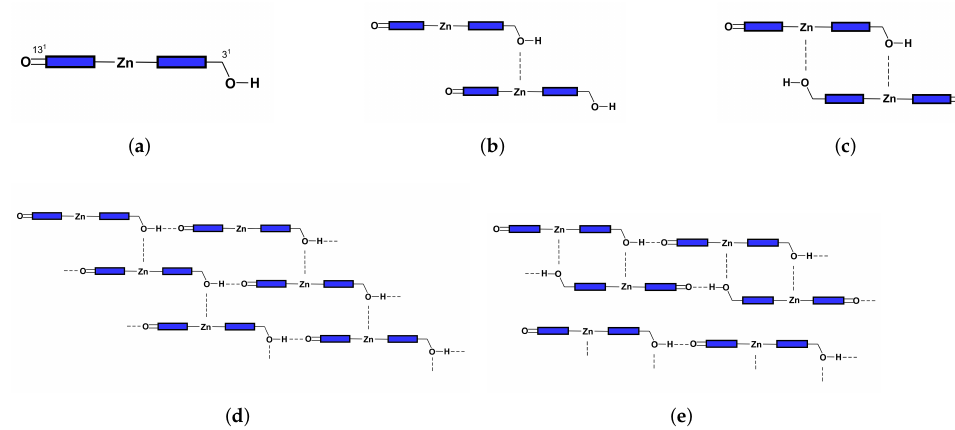
Figure 1. Monomer models of ( a ) Cd chlorin and ( b ) Zn chlorin.